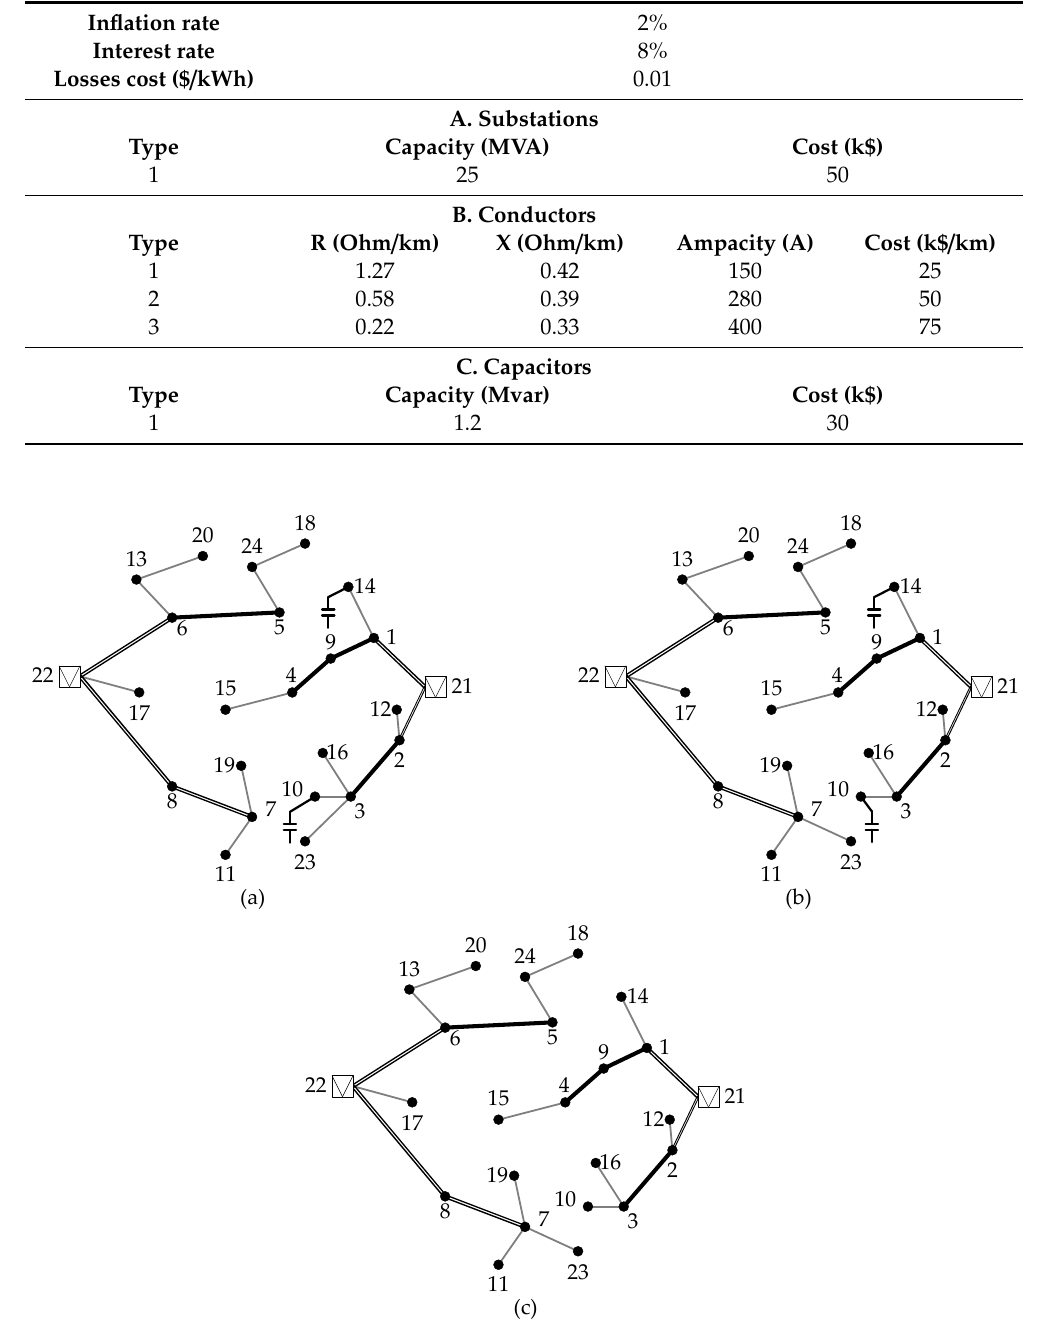
Figure 6. DNP solutions of the 24-bus distribution network in: ( a ) Case A, ( b ) Case B, and ( c ) Case C. Table 1. Future load points.